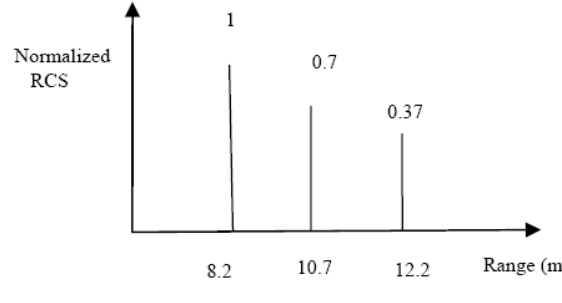
Figure 18. An extended target using corner